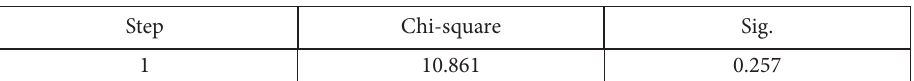
Table 15. The Hosmer and Lemeshow test